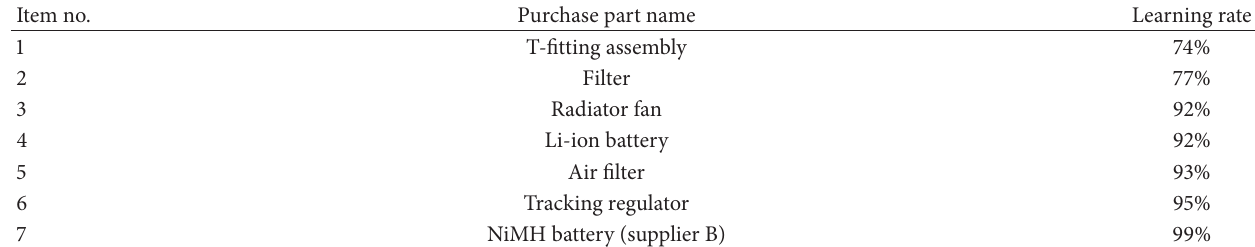
Table 3: Average pseudo learning rate of parts with plateau.